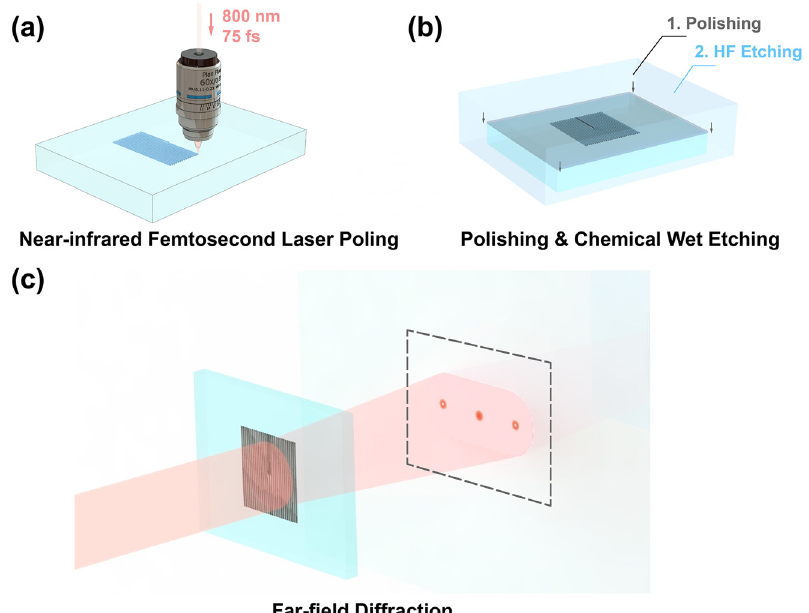
Figure 1: (a) The scheme of laser poling by using an oil immersion objective to focus the NIR laser beam. (b) The sample is first polished until the laser-poled area is exposed and is then etched in 40% HF solution. (c) We use the LWISCE technique to fabricate forkgratings withdifferent l orders, which is tested by optical